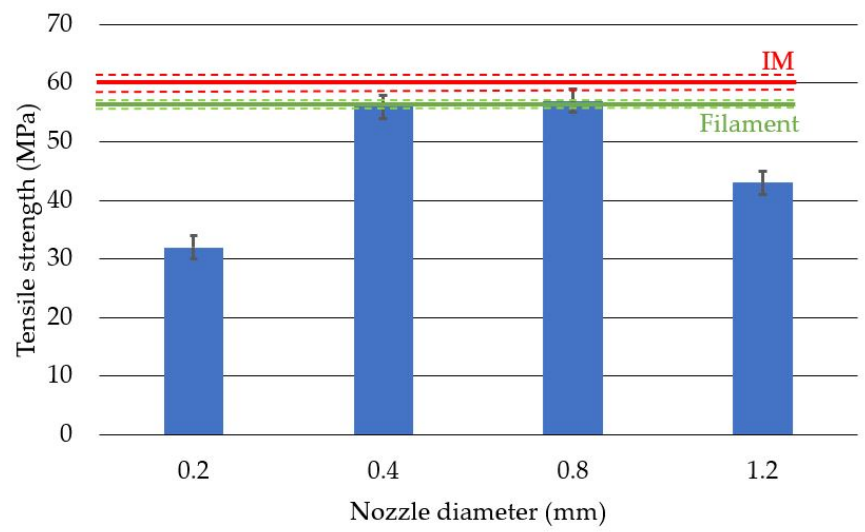
Figure 13. Average tensile strength values with standard deviation for samples produced with different nozzle diameters. IM—average value obtained for injected specimens. Filament—average value measured for single 1.75 mm filament fiber.